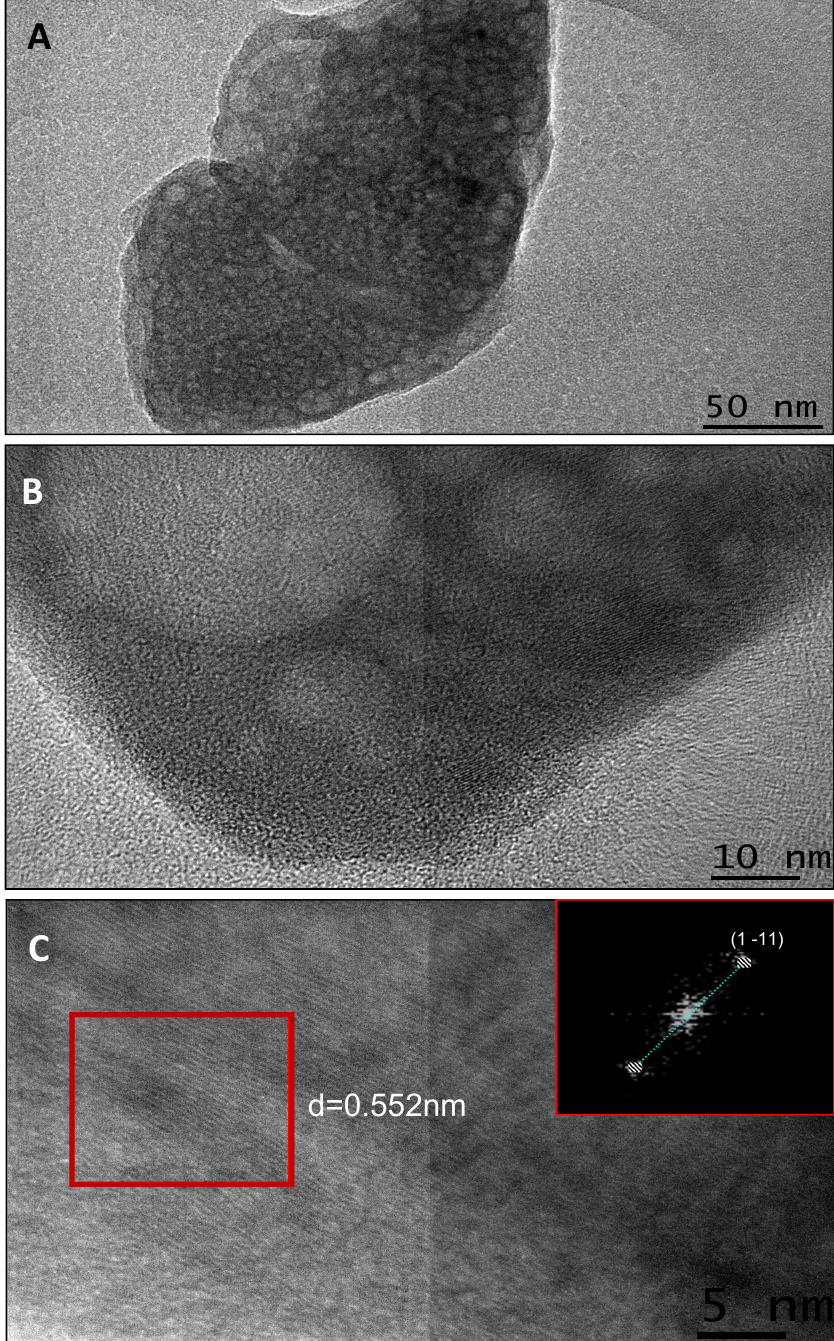
Figure 2. TEM micrographs of synthetic OCP crystals platelets, ( A , B ) Bubble—like defects revealed in a bright-field TEM image of OCP platelets, ( C ). HRTM image of OCP and its corresponding FFT analysis (inset).